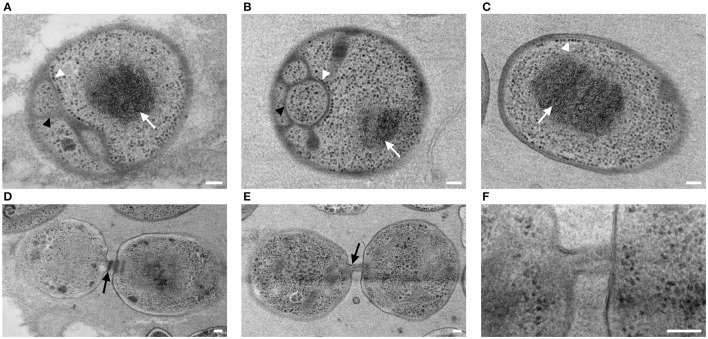
Subcellular organization and cell division of strain NH11T. High pressure frozen and freeze substituted cells of strain NH11T were subject to thin-sectioning and TEM analysis. Three representative sections of individual cells correspond to differences in subcellular organization of strain NH11T
(A–C). Cells always comprise a condensed nucleoid which is visible as a black structure (white arrow), while their cytoplasmic membrane can show different degrees of invaginations (A,B, black arrowheads). Some cells even lack any invagination of the cytoplasmic membrane (C). Some ribosomes (white arrowheads) are always located at the cytoplasmic membrane despite its degree of invagination (A–C). Dividing cells are interconnected by a tubular like structure (D–F). Between mother and daughter cell, sometimes a black structure, potentially correlating with a division ring, became visible (D, black arrow). This structure could only be observed in some sections, while it was absent in others (E–F). Bar, 0.1 μm.